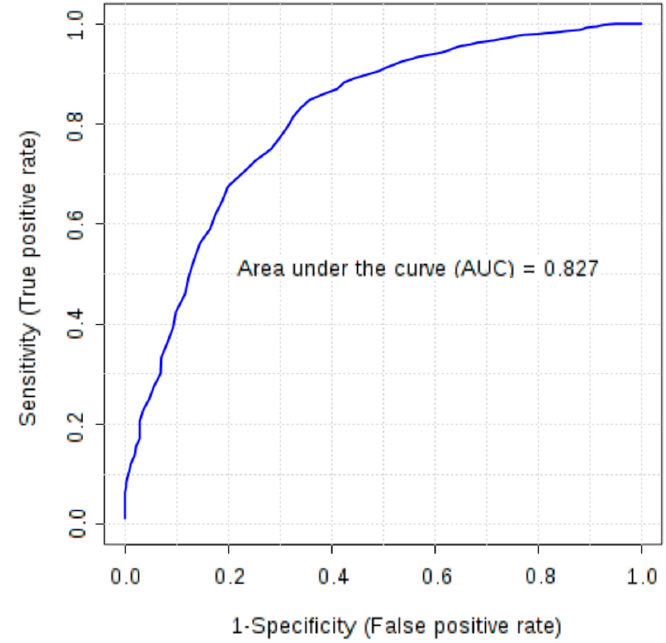
Figure 1. Multivariate receiver operating characteristic (ROC) curve representing correlation between serum concentrations of FGF-basic, follistatin, osteopontin and PDGF-AB/BB in ovarian cancer patients and control group (healthy subjects and patients with benign ovarian tumours).